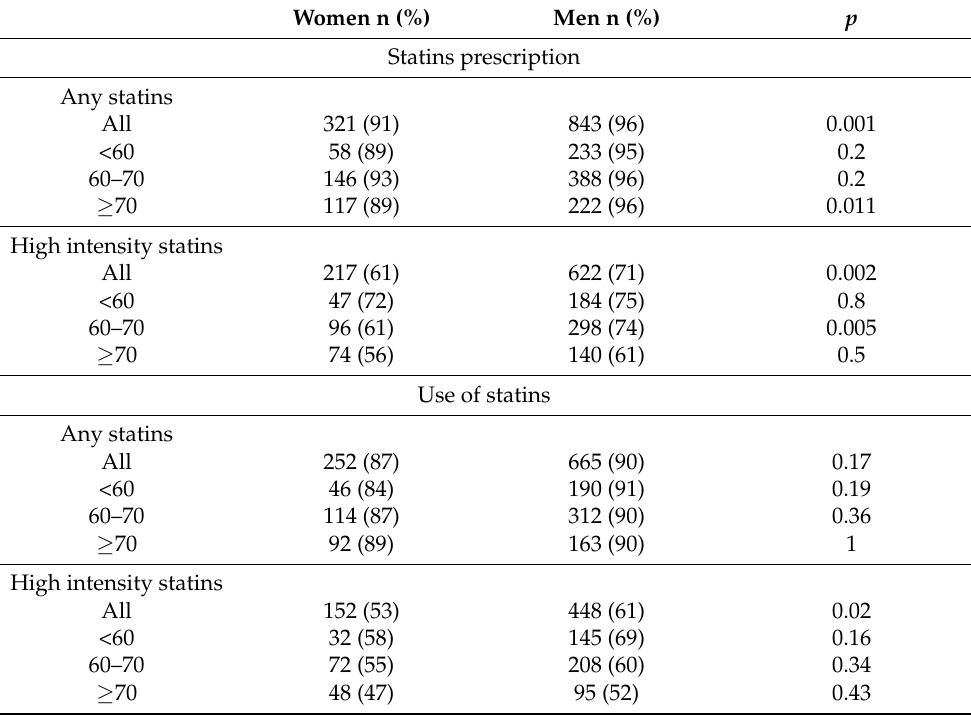
Table 6. Statins prescription and the use of statins in different age groups in men and women on discharge from hospital.